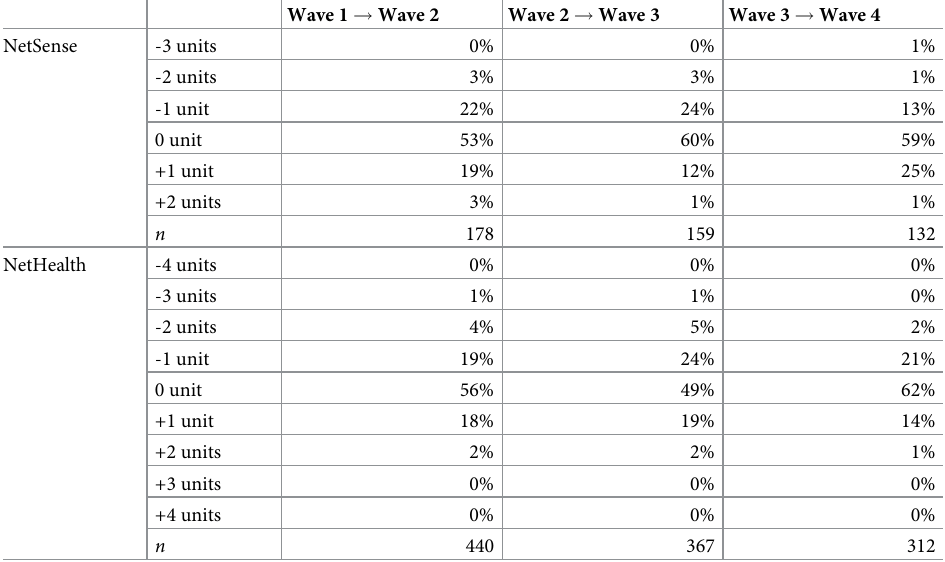
Table 2. Changing units in political orientation among NetSense and NetHealth study